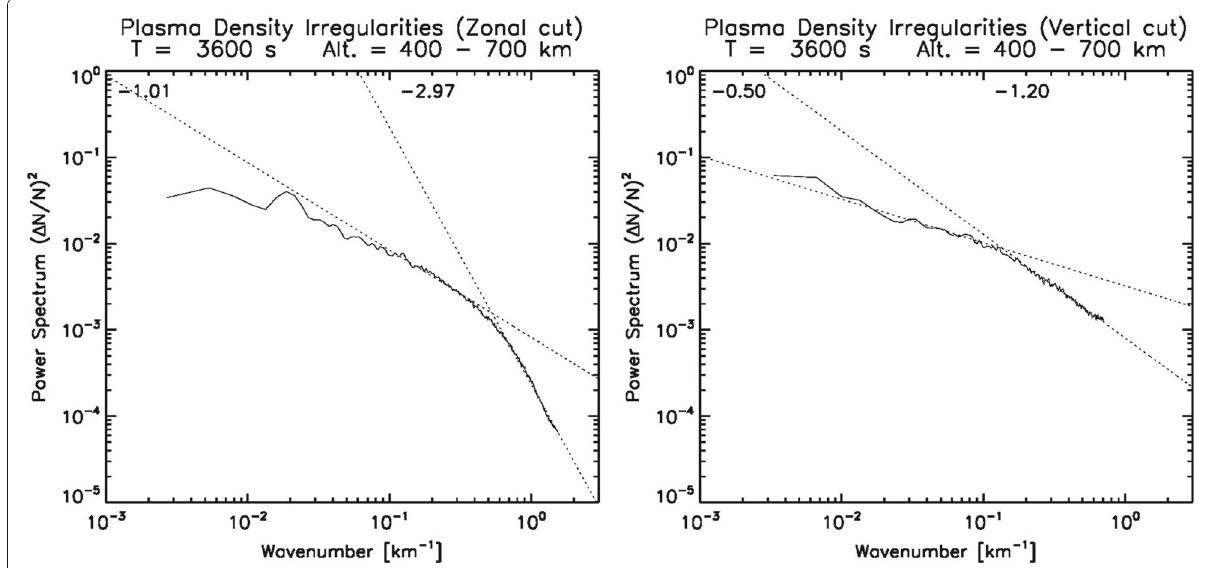
Fig. 10 Power spectral density plots of irregularities shown in Fig. 9. The power spectra were calculated using a simple FFT technique for each density profile along the zonal (vertical) coordinates and averaged over altitudes ranging from 400 to 700